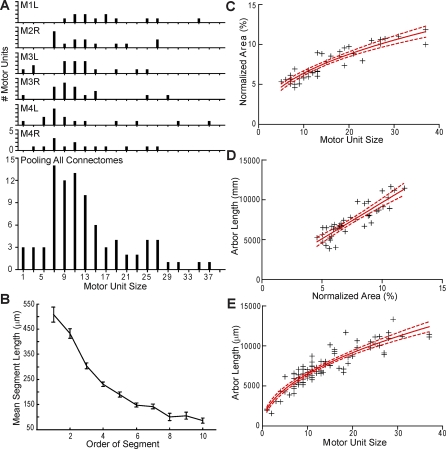
Common Features Exhibited by All Connectomes(A) Motor unit size distribution in each muscle was skewed towards smaller motor units, in agreement with previous physiological data (see text).(B) Mean axonal segment length decreased as segment order increased (71 axons from five muscles, see Figure S3 for more details). Error bars, standard error of the mean (SEM).(C) Normalized axonal cross-sectional area A scaled as the square root of motor unit size M (A ∼ M
0.4544, 95% CI of slope: 0.3903–0.5185, R
2 = 0.8445; n = 40). In (C–E) red solid lines are best fitting; red dotted lines show 95% CI.(D) Axonal arbor length L scaled linearly with A (R
2 = 0.7775; n = 40).(E) L scaled as the square root of M (L ∼ M
0.4938, 95% CI of slope: 0.4428–0.5447, R
2 = 0.8394; n = 87).